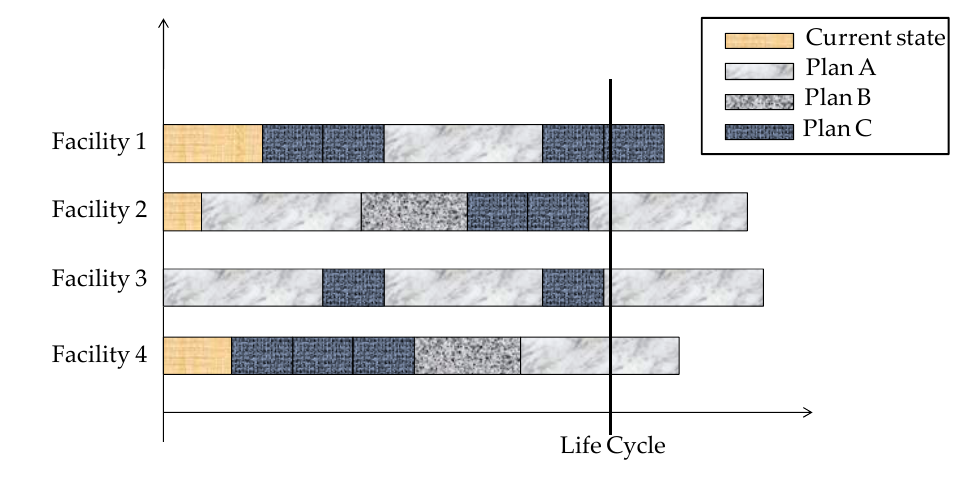
Figure 6. Possible result of Model-I.